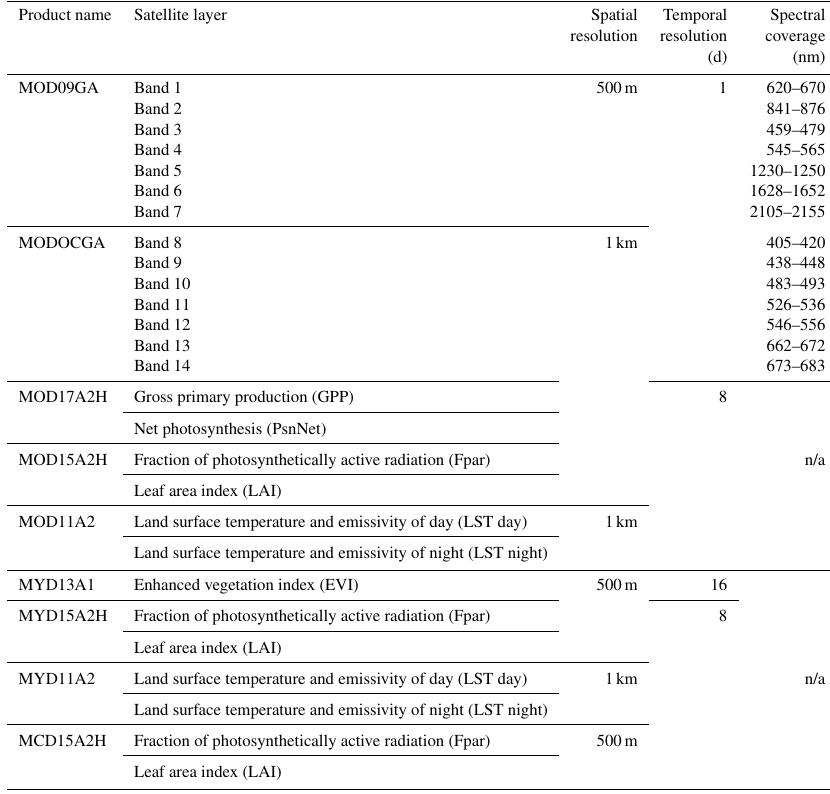
Table B1. MODIS reflectance bands and products database.